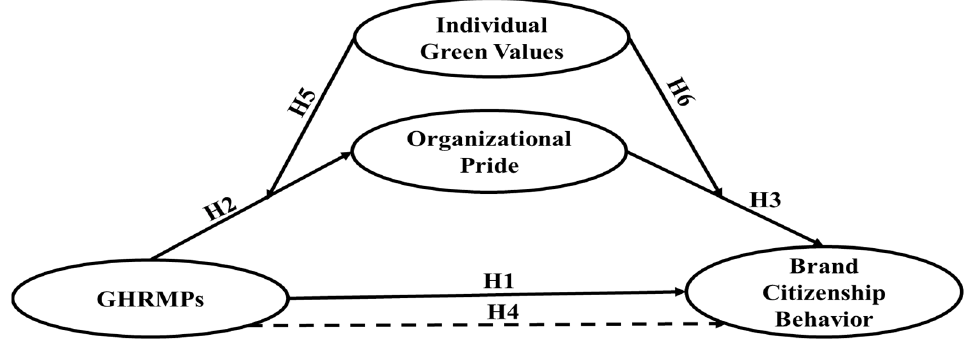
Figure 1. The research model.